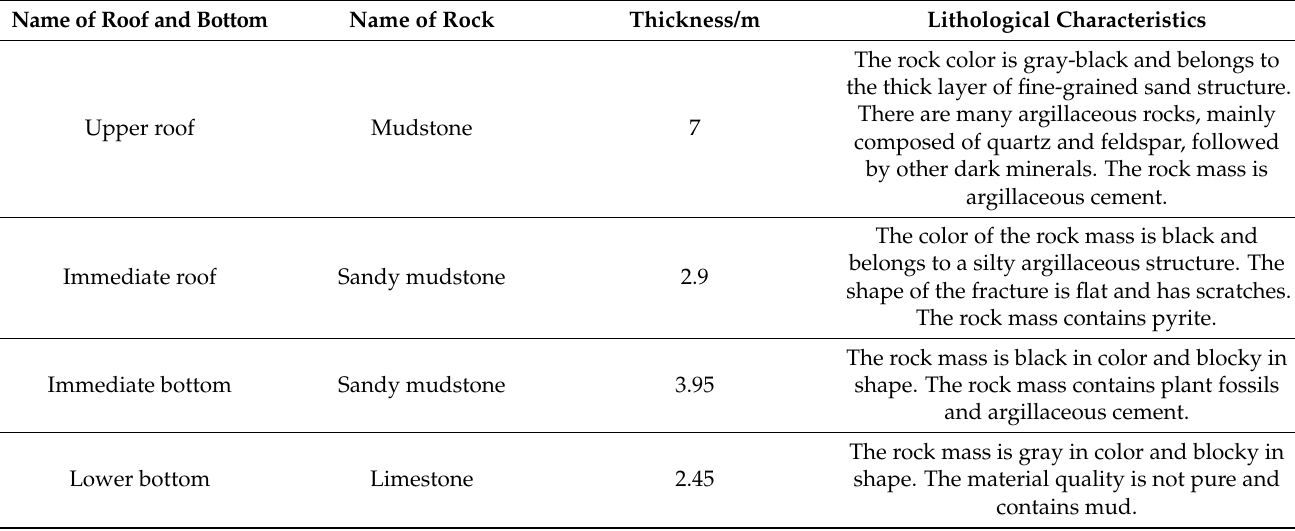
Figure 1. The relative positions of cavern groups. Table 1. The lithologic characteristics of the roof and floor.